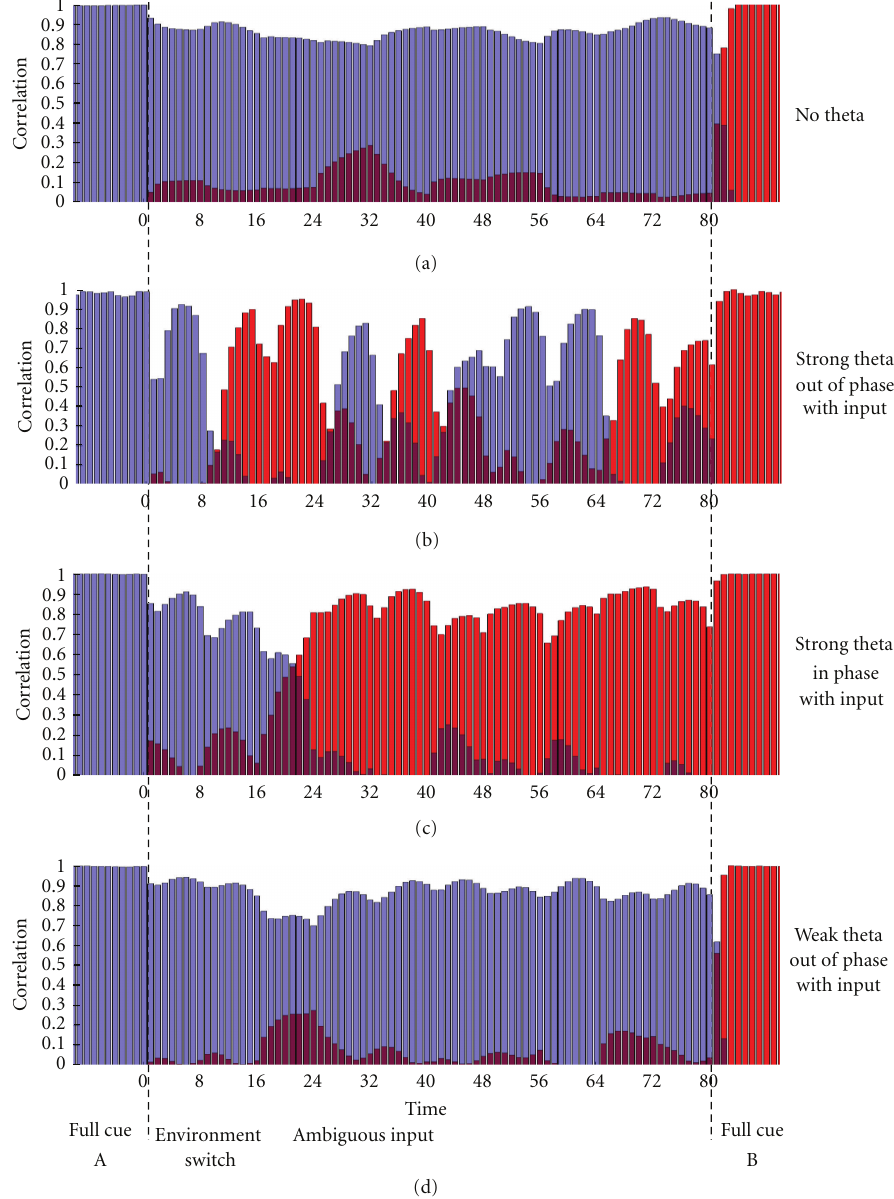
Figure 3: Results of our simulation of the teleportation experiment. Bars represent correlation with the two di ff erent representations at each time step. Di ff erent plots are relative to di ff erent conditions: “strong” is 80% variation in firing rate and sparsity between the peak and the through and “weak” is 20% variation; in phase means Δ = 0 ◦ and out of phase means Δ = 180 ◦